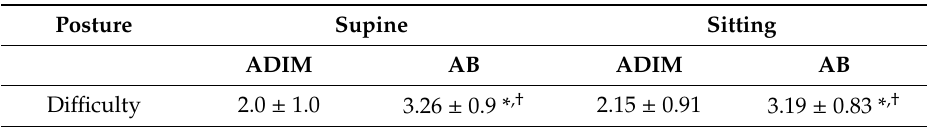
Table 1. Subjective di ffi culty.